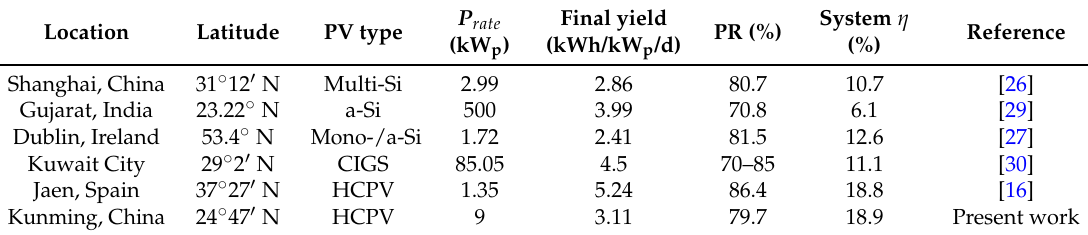
Table 1. Performances of the present HCPV system located at Kunming as compared to previously reported PV/HCPV systems constructed in different locations (the DNI intensity is used for HCPV system when calculating the system